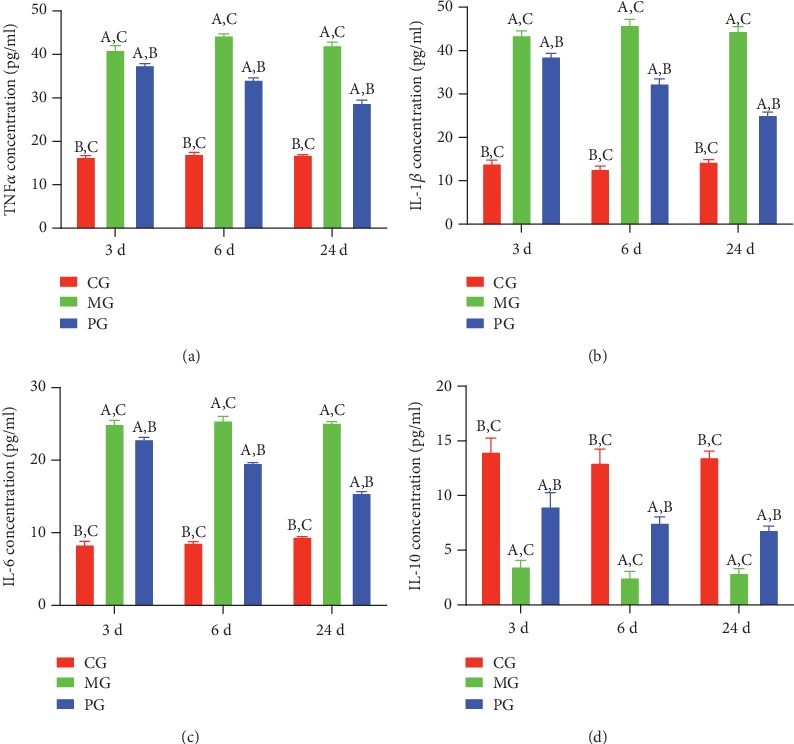
The effects of picroside II on the serum levels of inflammatory cytokines. (a) TNFα. (b) IL-1β. (c) IL-6. (d) IL-10. aP < 0.05 vs. the CG group, bP < 0.05 vs. the MG group, and cP < 0.05 vs. the PG group. n = 10 for each group.